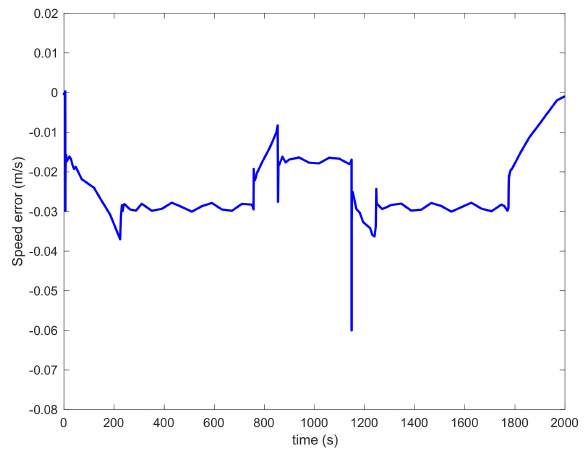
Figure 7. Speed error of ATSM-FTC-RBFNN.